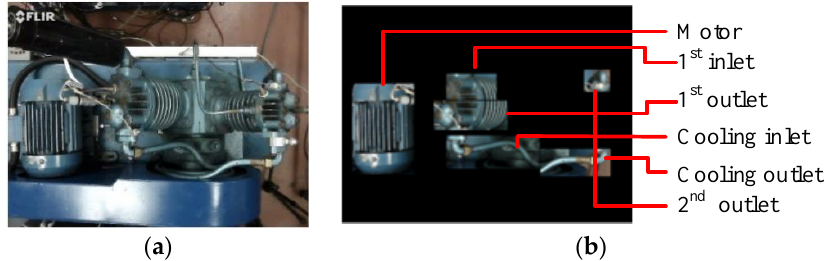
Figure 3. The main regions of images of interest: ( a ) image of the test rig, ( b ) six selected regions.